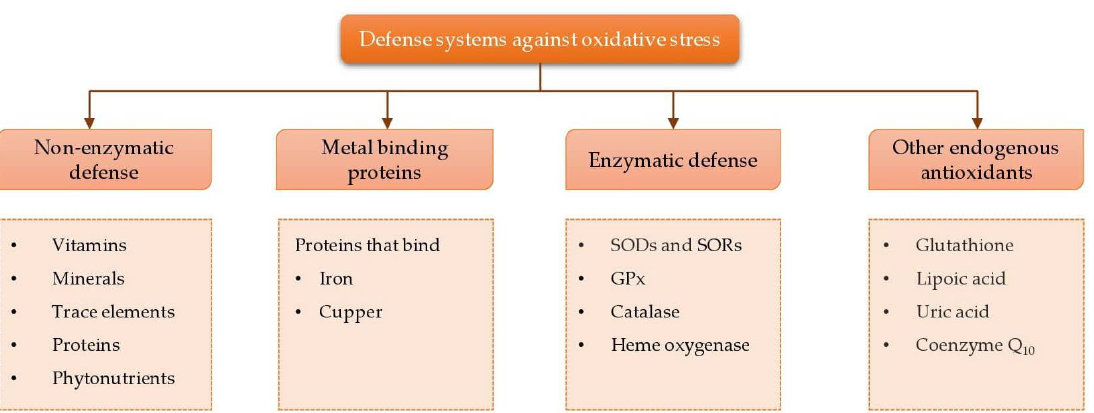
Figure 8. Types of defense systems against free radical formation in biological systems under stress conditions that affect performance, health, and well-being in human and farm animals. Defense sys- tems can be categorized into enzymatic and non-enzymatic defense systems, metal binding proteins, and other endogenous antioxidants.